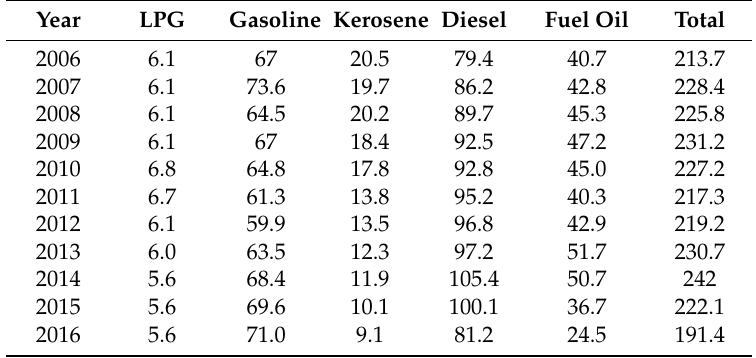
Table 1. Main petroleum products consumption during 2006–2016 (million liters per